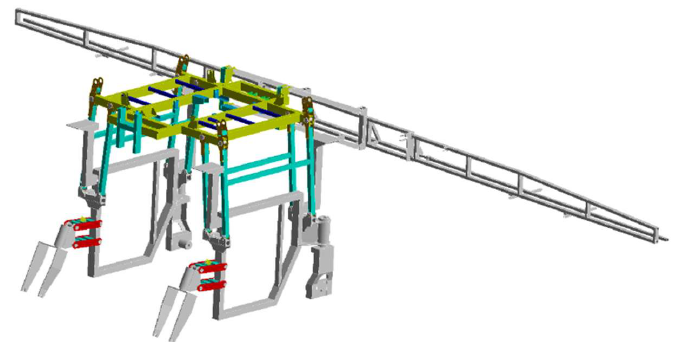
Figure 2. The color structure in the Figure is the part where the shell element is used in the simulation analysis of the sprayer.